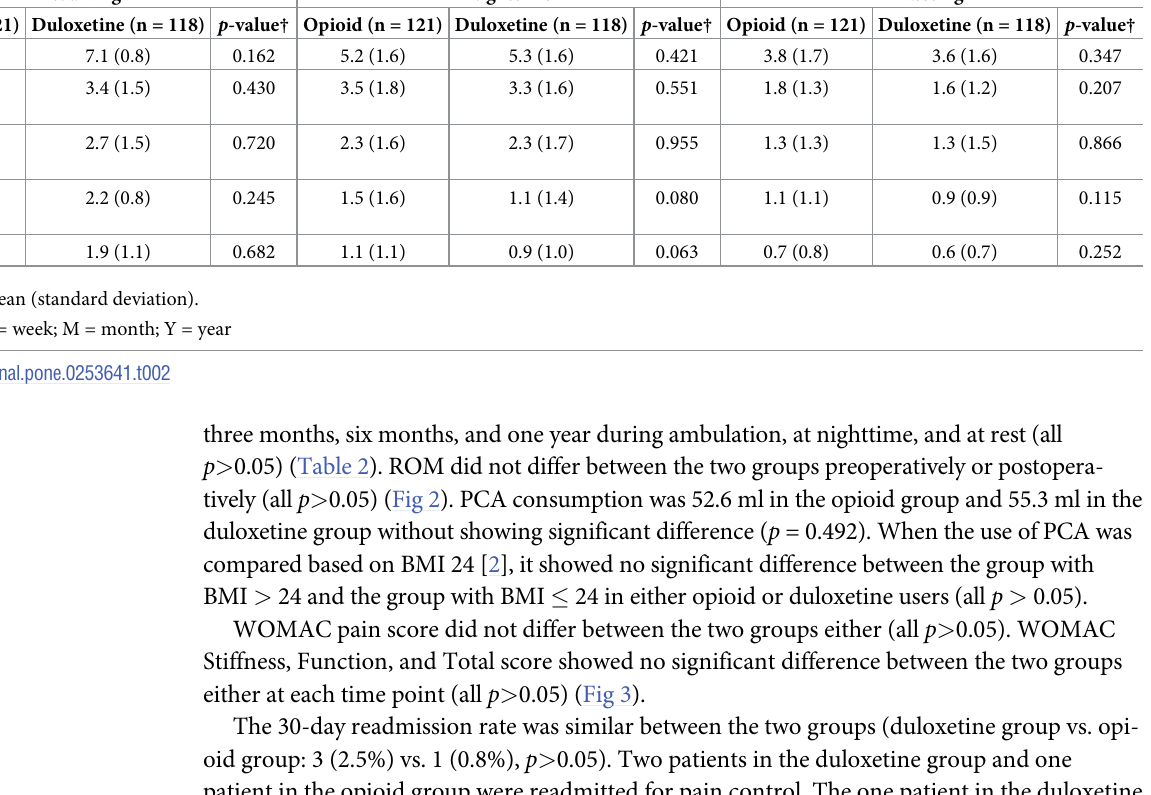
Table 2. Pain VAS on walking, nighttime, and resting � . Walking Nighttime Resting